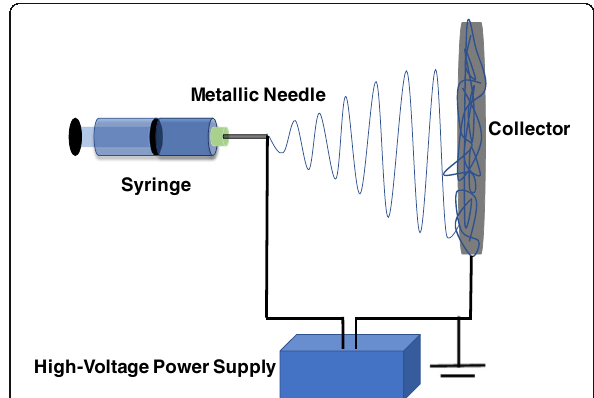
Fig. 1 The basic laboratory setup for